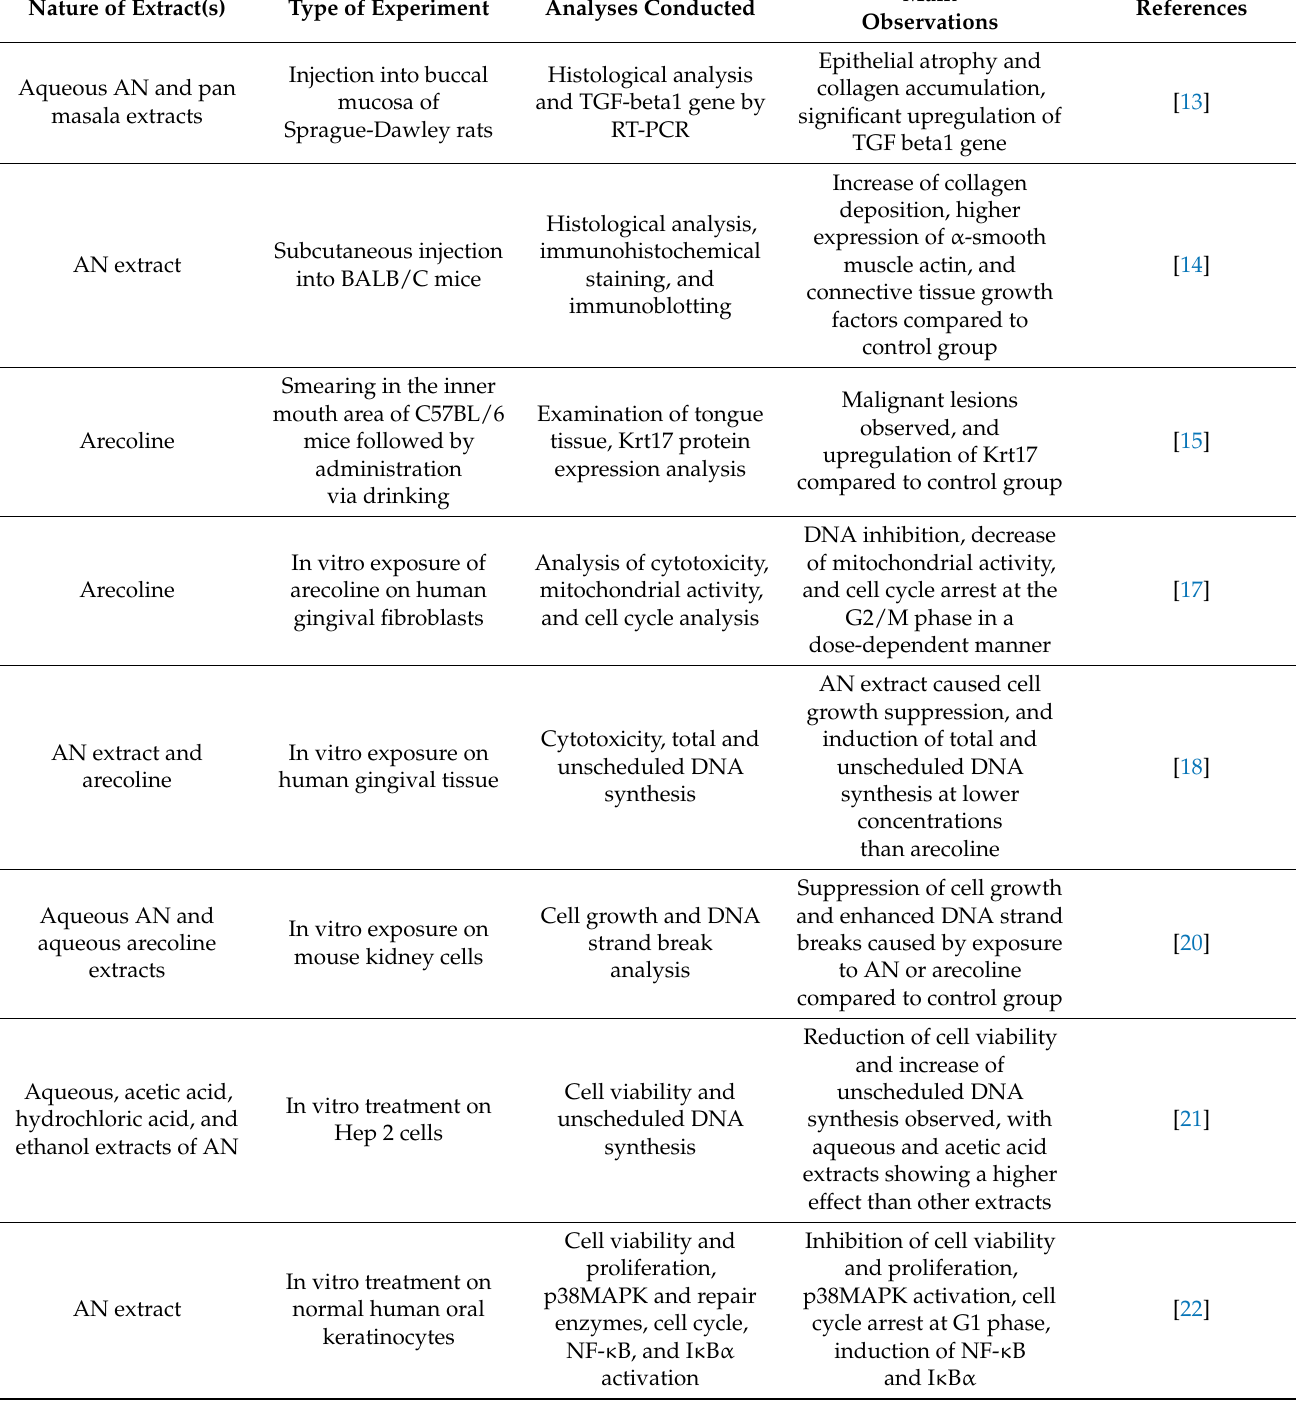
Table 1. Summary of Key